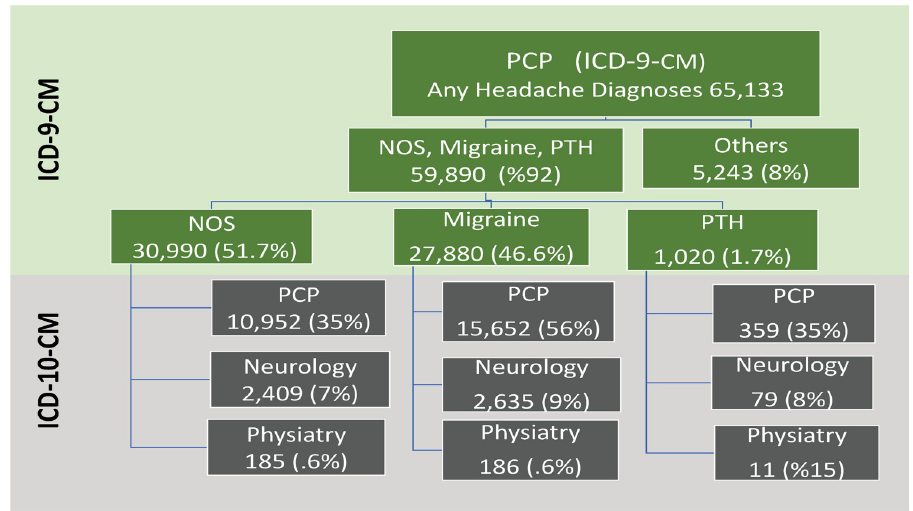
Fig 3. Utilization of ICD-10-CM headache coding per provider type as shown in the black colored boxes.